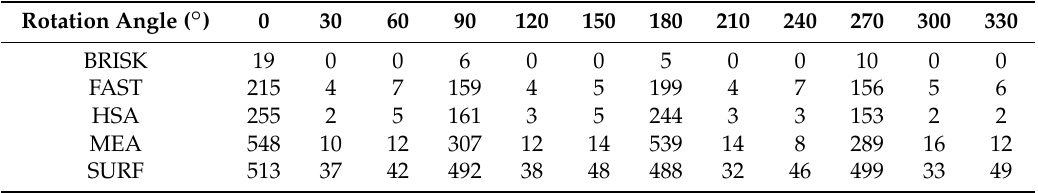
Table 2. The number of MIPs for the computer-aided rotation of the search key by the given rotation angle (for the Figure 3 case).